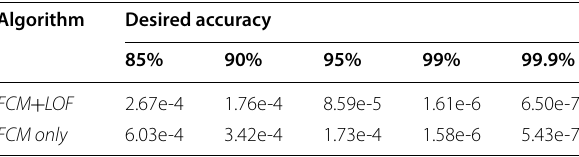
Table 3 Actual time (percentage) with different desired